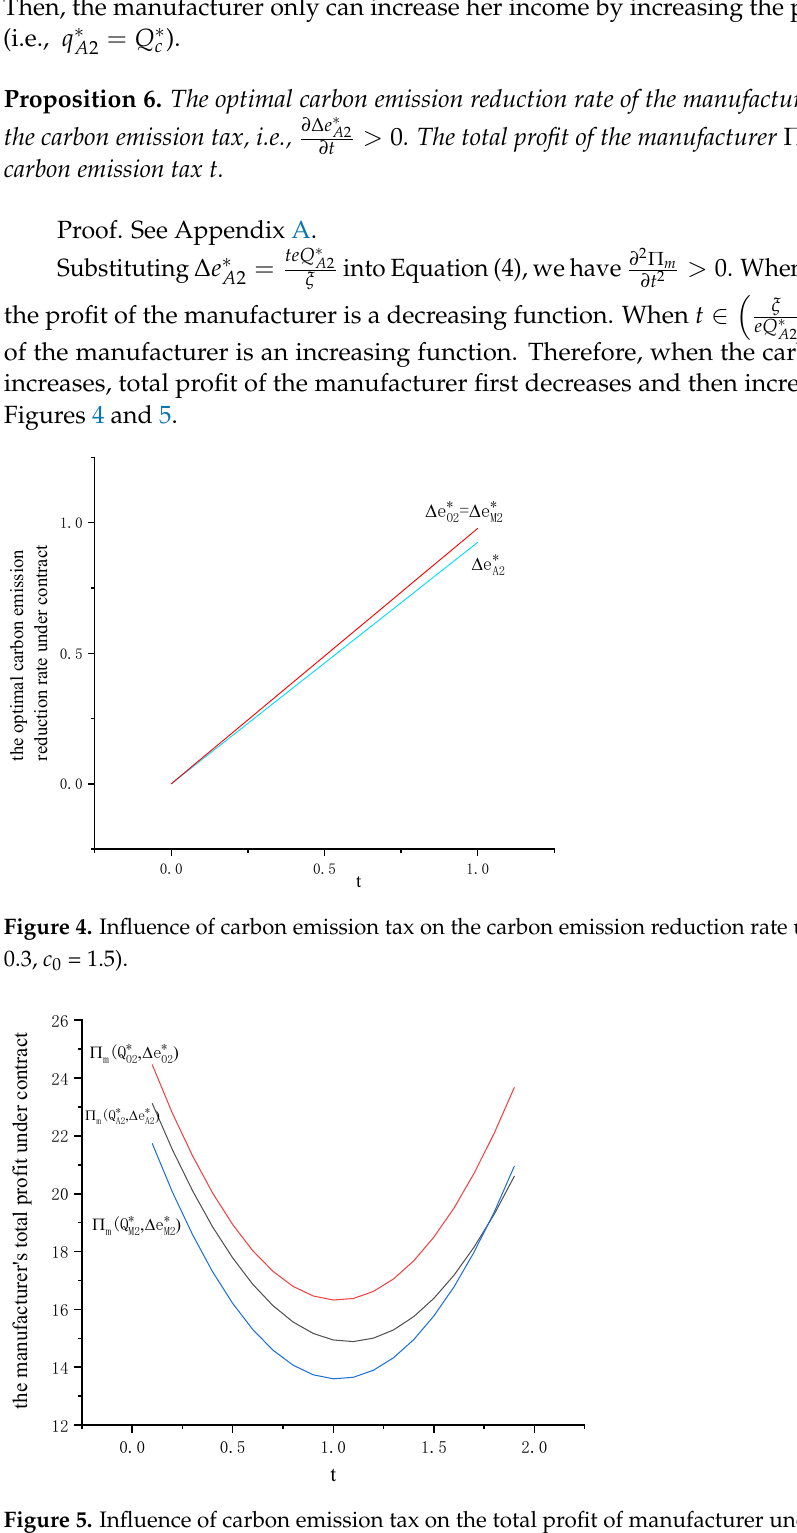
Figure 6. The cash flow of supply chain with the option contract. 𝑇 (cid:2868) : Retailer pays the option fee 𝑐 (cid:3042) 𝑞 (cid:3016) in advance. 𝑇 (cid:2869) : 𝑄 (cid:3016) − ∫